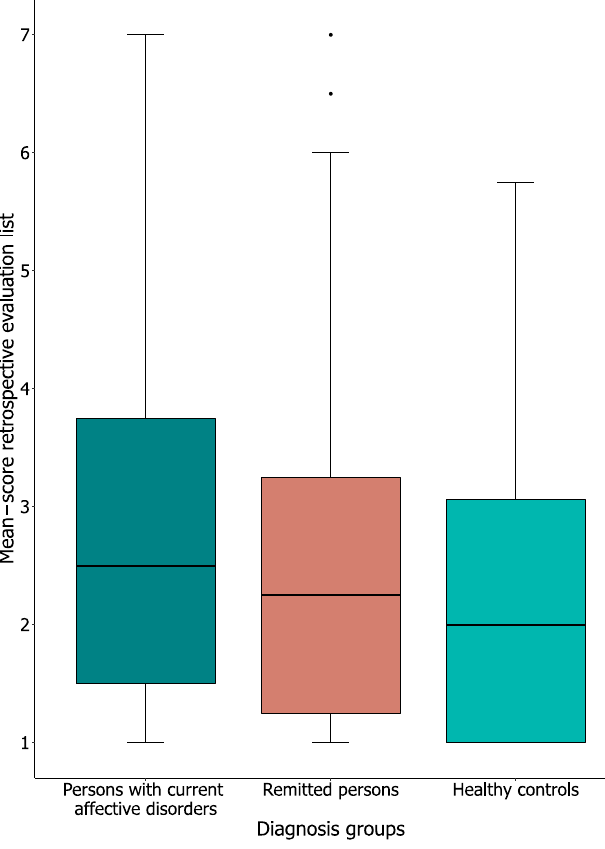
Figure 3. Mean scores of the retrospective evaluation of experienced burden. Note: Mean scores of the retrospective evaluation; a reflection of experienced burden over the whole EMA monitoring period. Score range between 1 and 7, higher score indicates more burden. Thick black line shows the median, error bars show the interquartile range (IQR), whiskers show +/ − 1.5 IQR, and (cid:8) = outlier, deviates by ≥ 1.5 ×